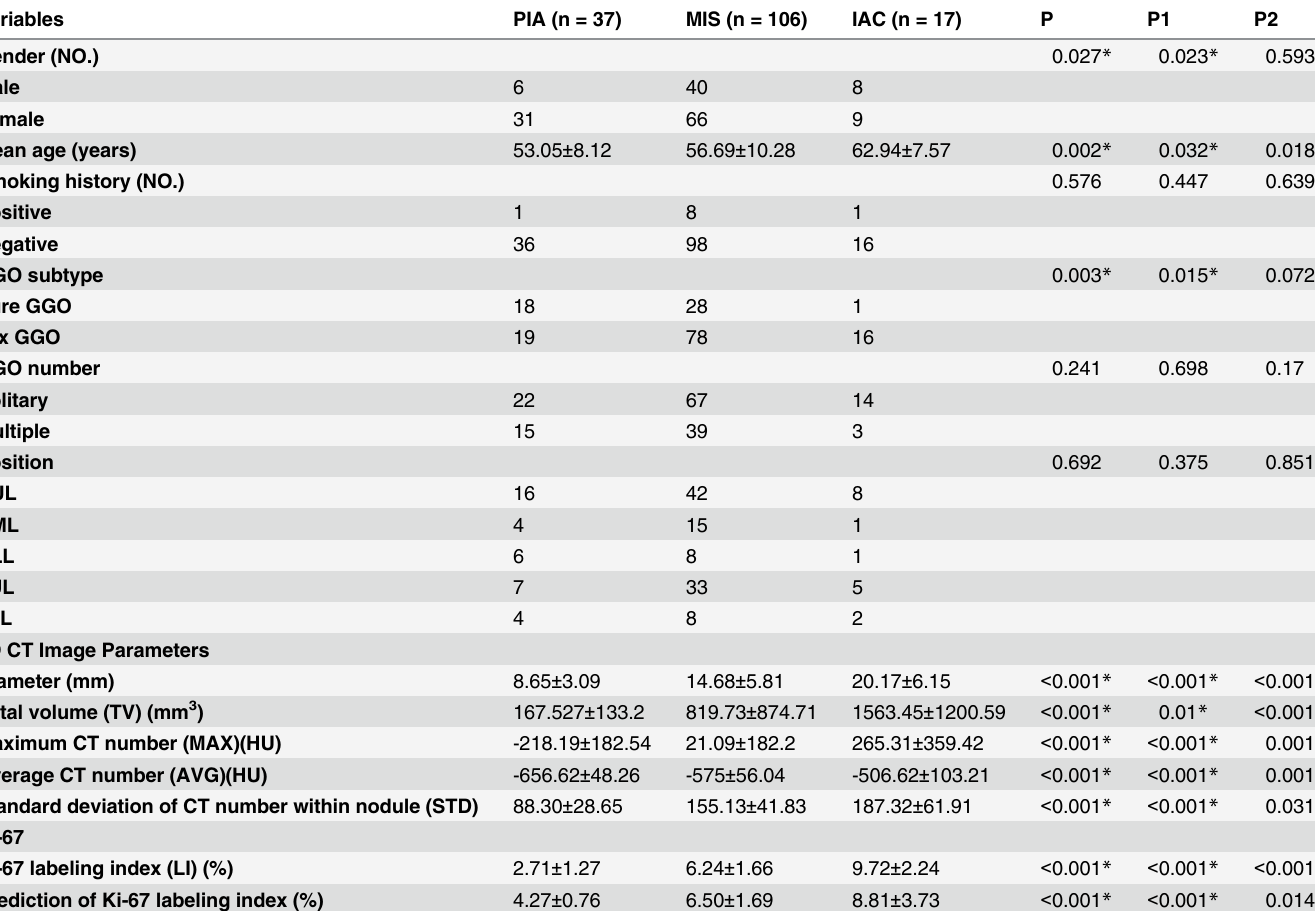
Table 1. Clinical, Radiologic and Pathologic Characteristics of All GGO Nodules with different pathologic categories (n = 160).